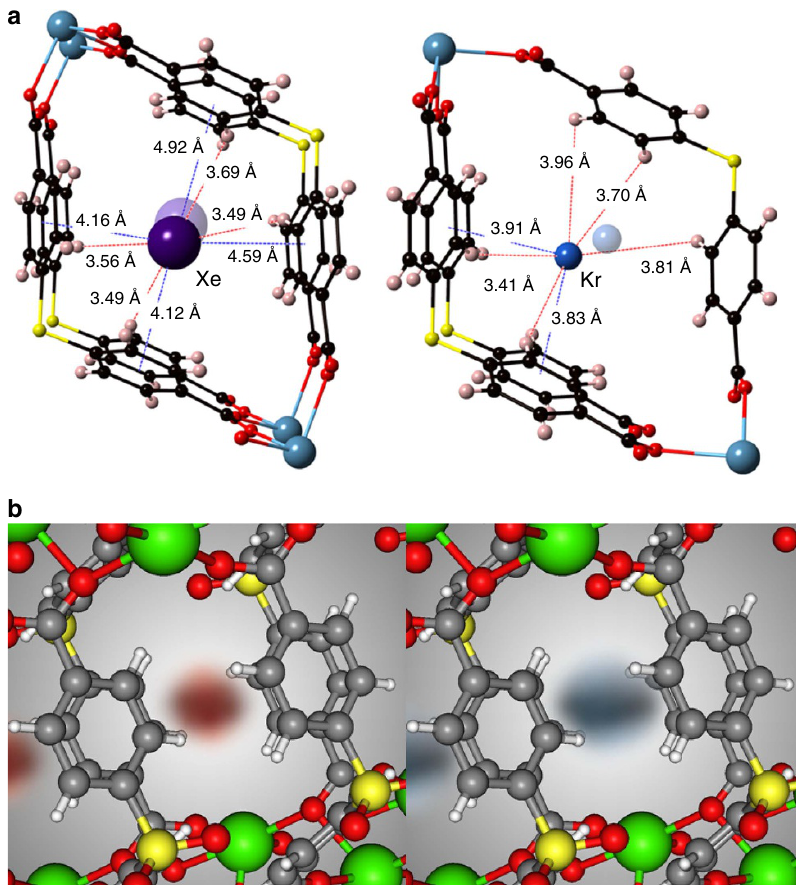
Figure 4 | Xe and Kr adsorption sites in SBMOF-1. ( a ) Xe and Kr positions determined by single-crystal X-ray diffraction. ( b ) Spatial probability densities from recording adsorbate positions during pure-component grand-canonical Monte Carlo simulations at 1bar and 298K (Xe, red; Kr,